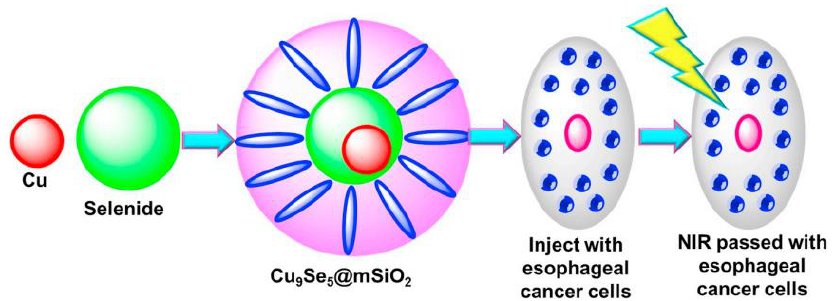
Figure 4. Portrayal of the Cu9S5@MS nanoparticles synthesis and application as a dual functional treatment stage for esophageal squamous carcinoma treatment.